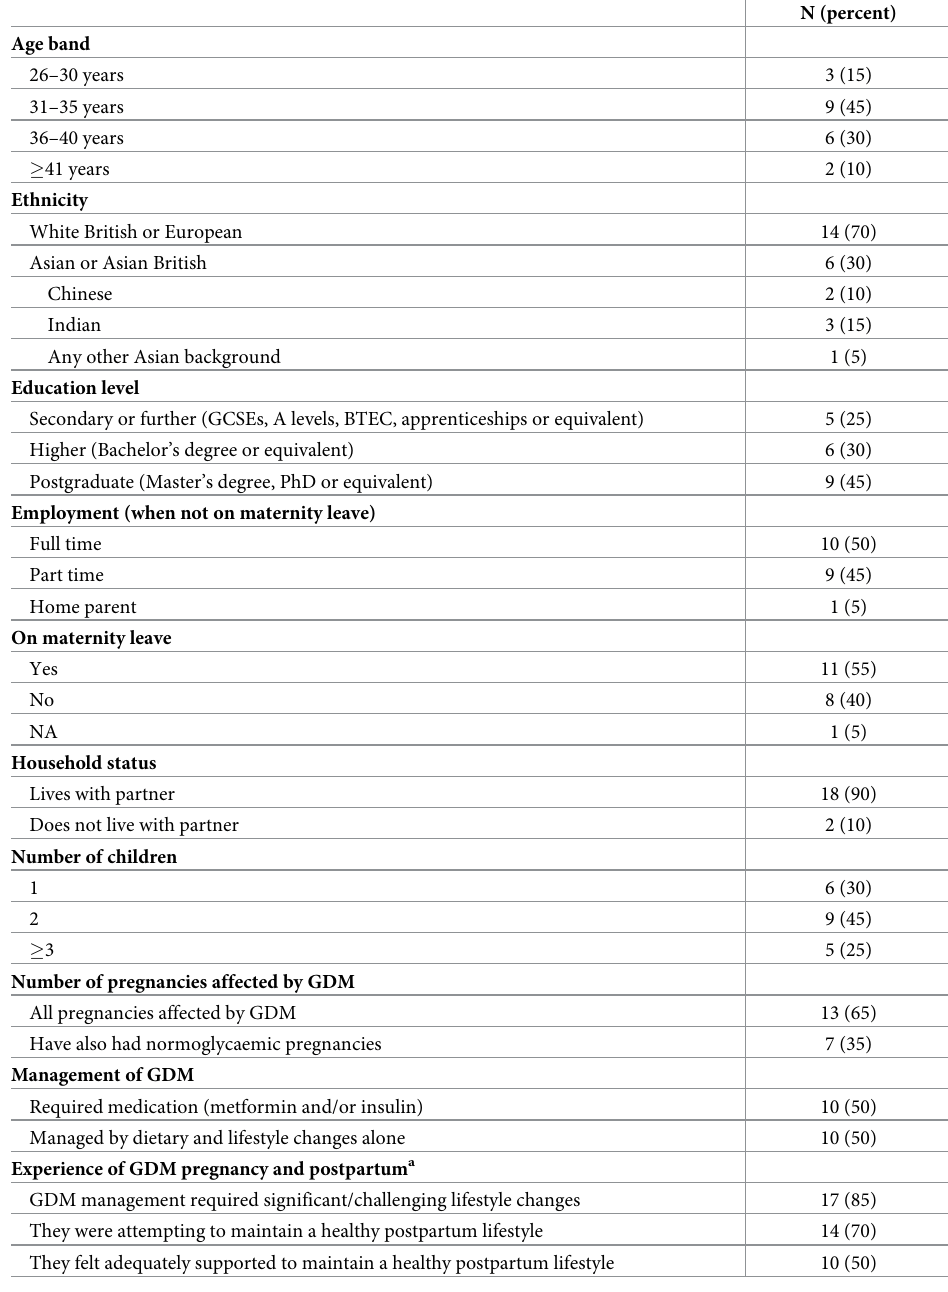
Table 1. Participant characteristics at the time of the